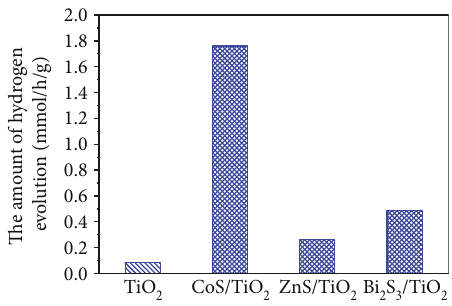
Figure 5: Photocatalytic H